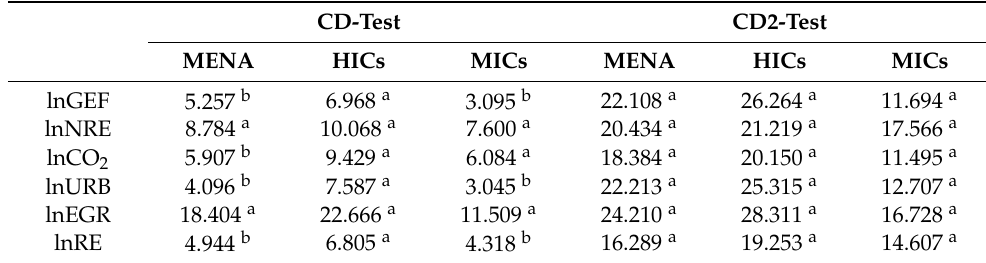
Table 5. Pesaran Cross-Sectional Dependency Results by Economic